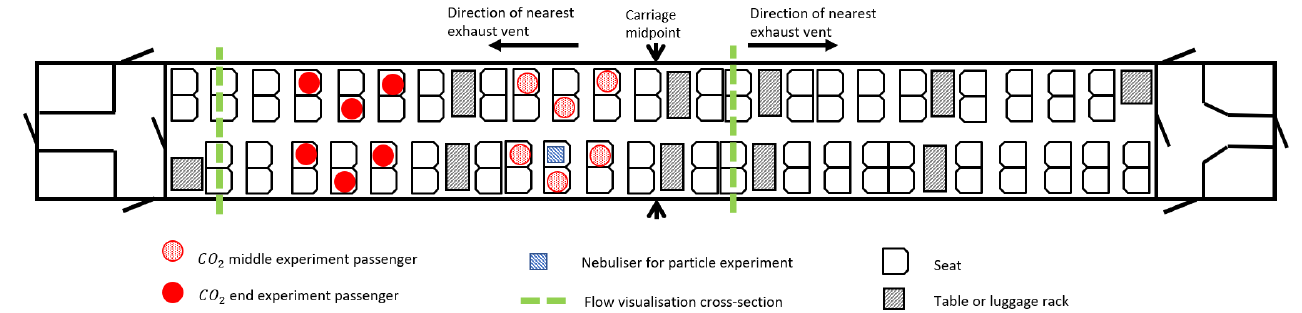
Figure 1. Schematic of carriage seat layout and experimental layouts for this study. Red circles indicate the position of passengers for the end experiments (full) and middle experiments